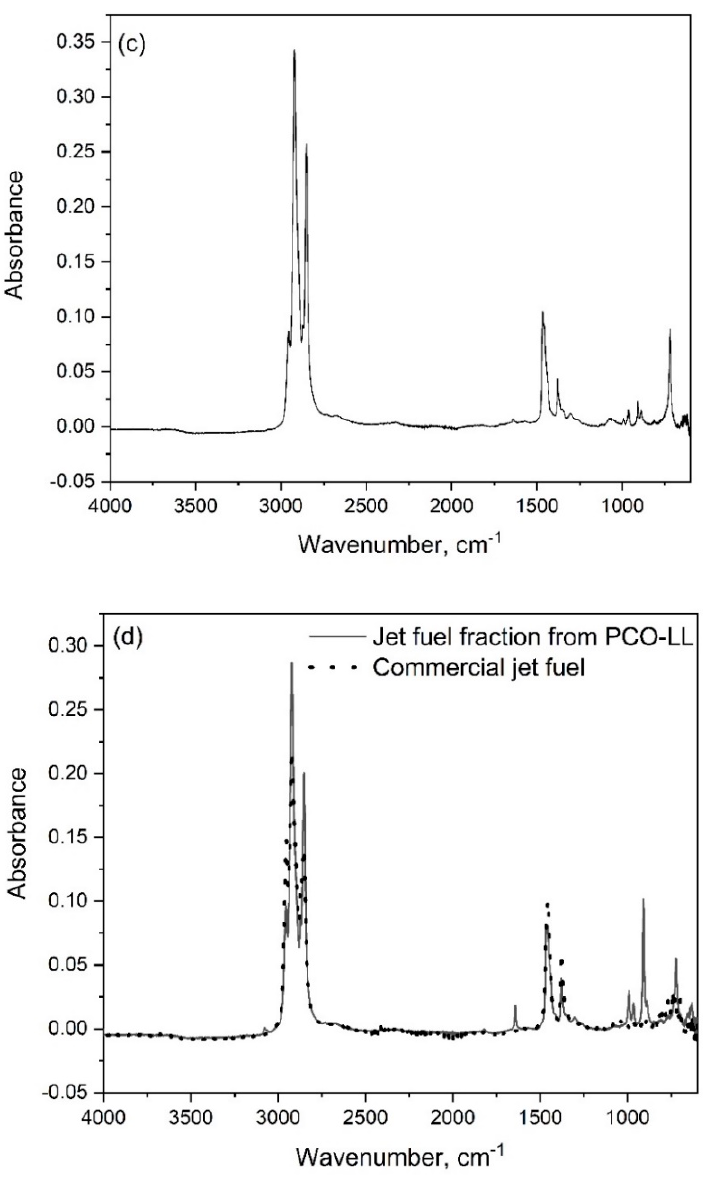
Figure 7. FT-IR spectra of the distillate fractions of plastic crude oil obtained after pyrolysis of landfill liner plastic waste (PCO-LL): ( a ) gasoline range, ( b ) aviation range fuel, ( c ) gas oil plus range, and ( d ) comparison of aviation range fuel fraction (from PCO-LL) with commercial jet fuel. 1 H-NMR spectroscopy was performed for the quantification of hydrocarbons, and